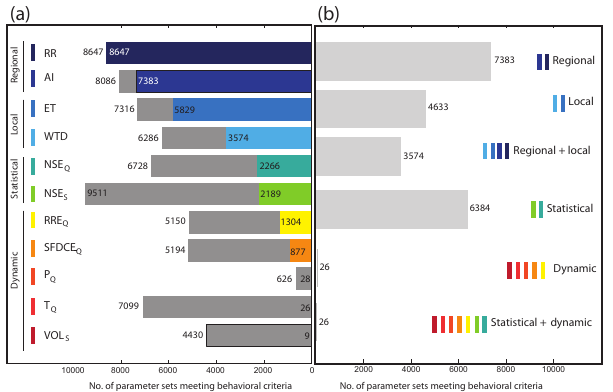
Figure 4. Number of parameter sets retained by each stage of the conceptual framework, shown for (a) individual metrics and (b) groups of metrics specified in Fig. 2. For individual met- rics (a) , bars in color indicate the number of parameter sets retained by sequential application of each of the steps, moving from top to bottom. Bars in grey indicate the number of parameter sets removed if each constraint is applied independent of the others. For groups of constraints (b) , bars indicate the number of parameter sets that meet all constraints in a given